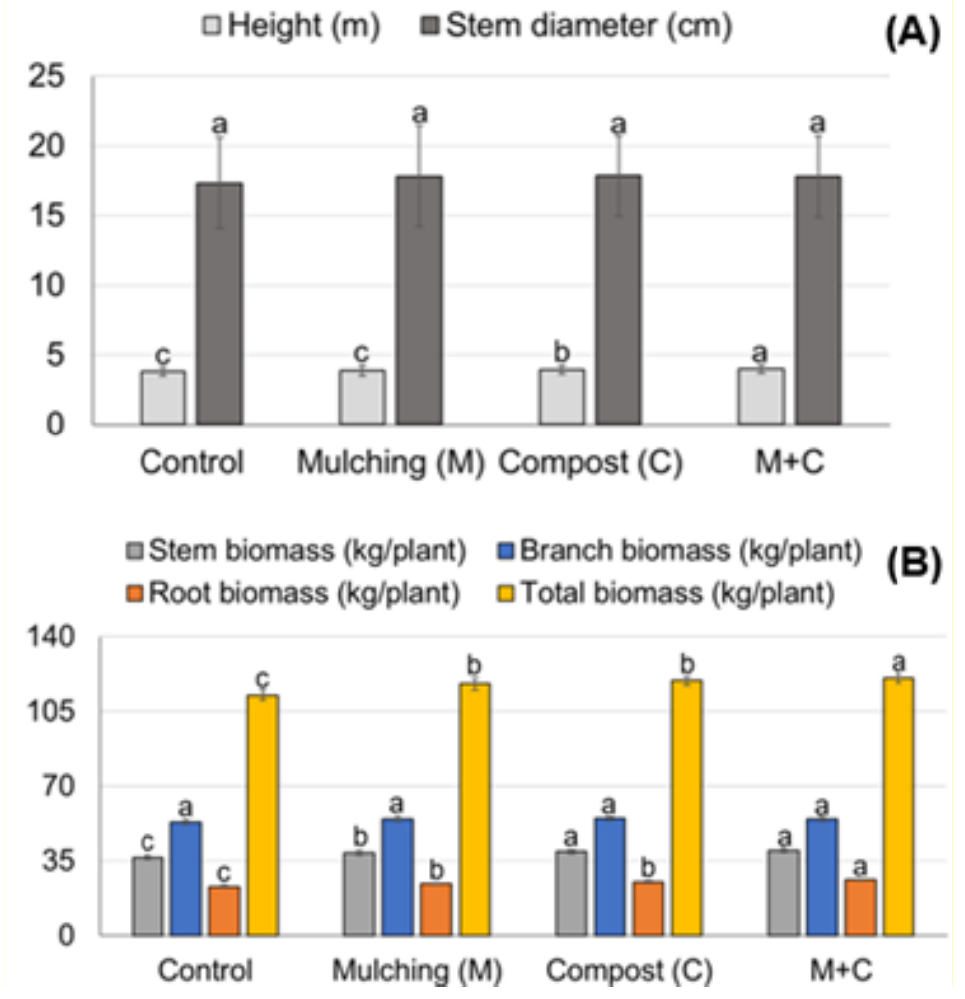
Figure 4. Plant traits ( A ) and biomass production ( B ) among the studied treatments of organic residues management in a subtropical ecosystem, Curitibanos, Santa Catarina, Southern Brazil. Different small letters into each line differ by Bonferroni’s test ( p < 0.05). Mean values (n = 360) followed by the standard deviation in parenthesis.